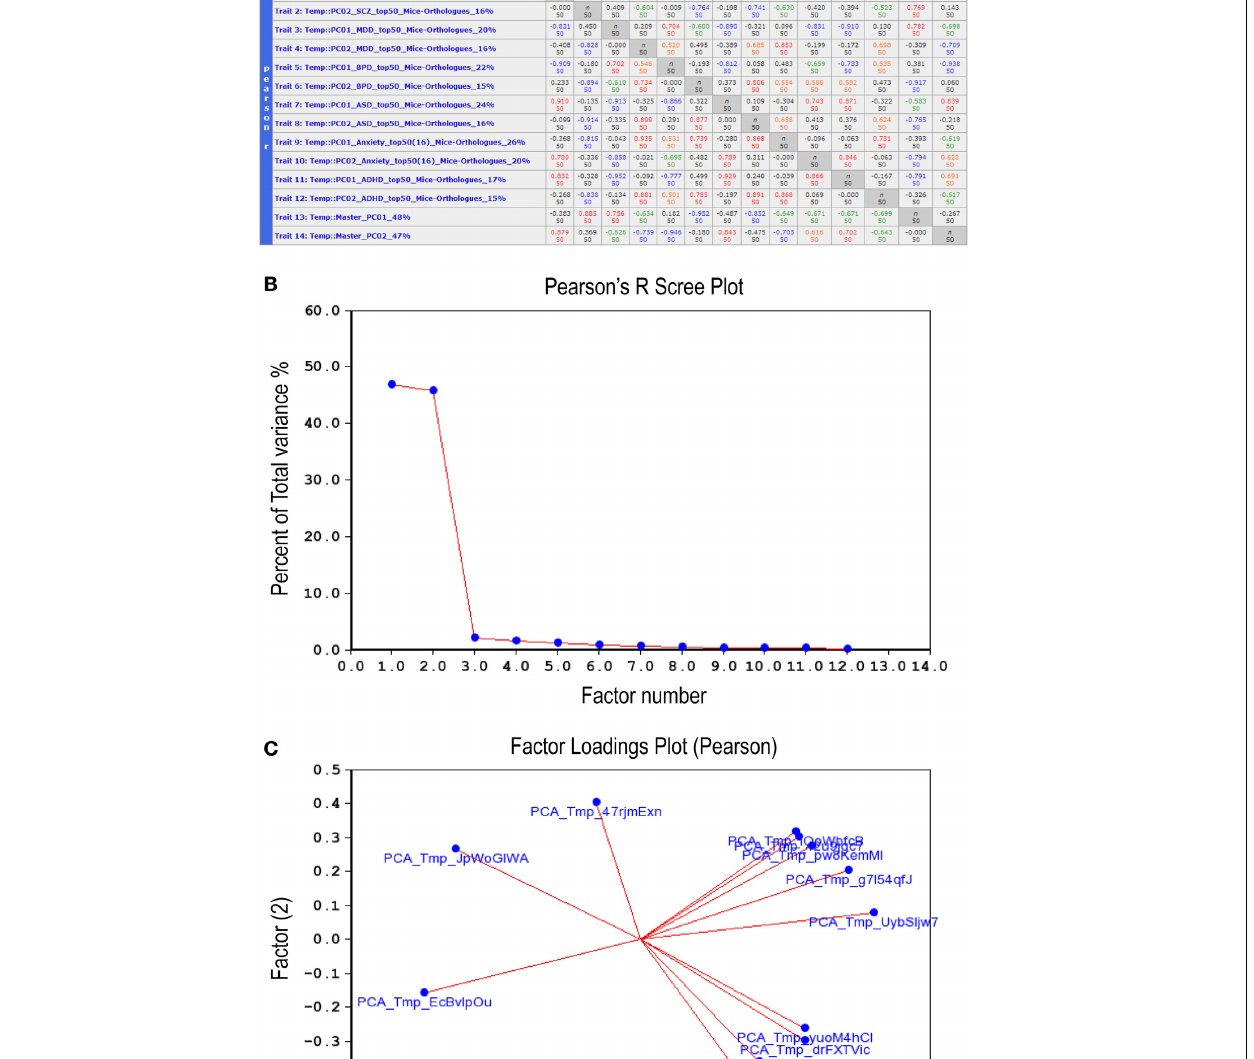
product-moment correlations; upper right cells list Spearman rank order correlations. Each cell also contains the n of cases. Values higher than 0.7 are displayed in red; those between 0.7 and 0.5 in orange; between − 0 . 5 and − 0 . 7 in green; values lower than − 0 . 7 are in blue. Scree plot (B) depicts the percentage of total variance across the 12 synthetic PC traits ( > 45%) that is accounted for by each one of the Master PCs. Factors loading plot (C) depicts the relative vector-wise contribution to both Master PCs arriving from each of the 12 disorder-specific PC traits.